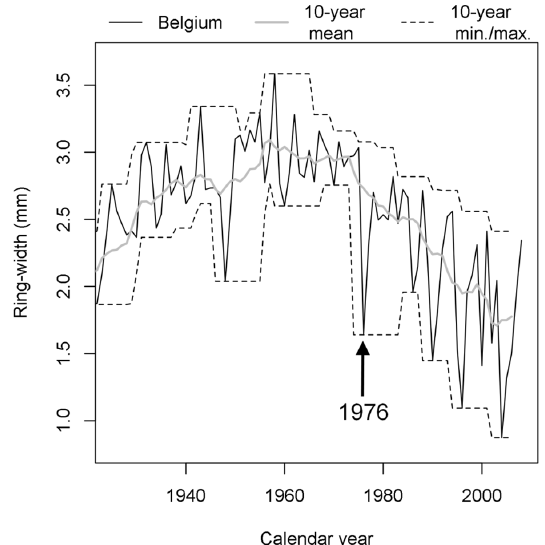
Figure 6. Mean radial growth of the 149 beech trees with 10 ‐ year moving mean, minimum, and maximum trends to illustrate the increased yearly growth reductions and their influence on the overall growth decrease.